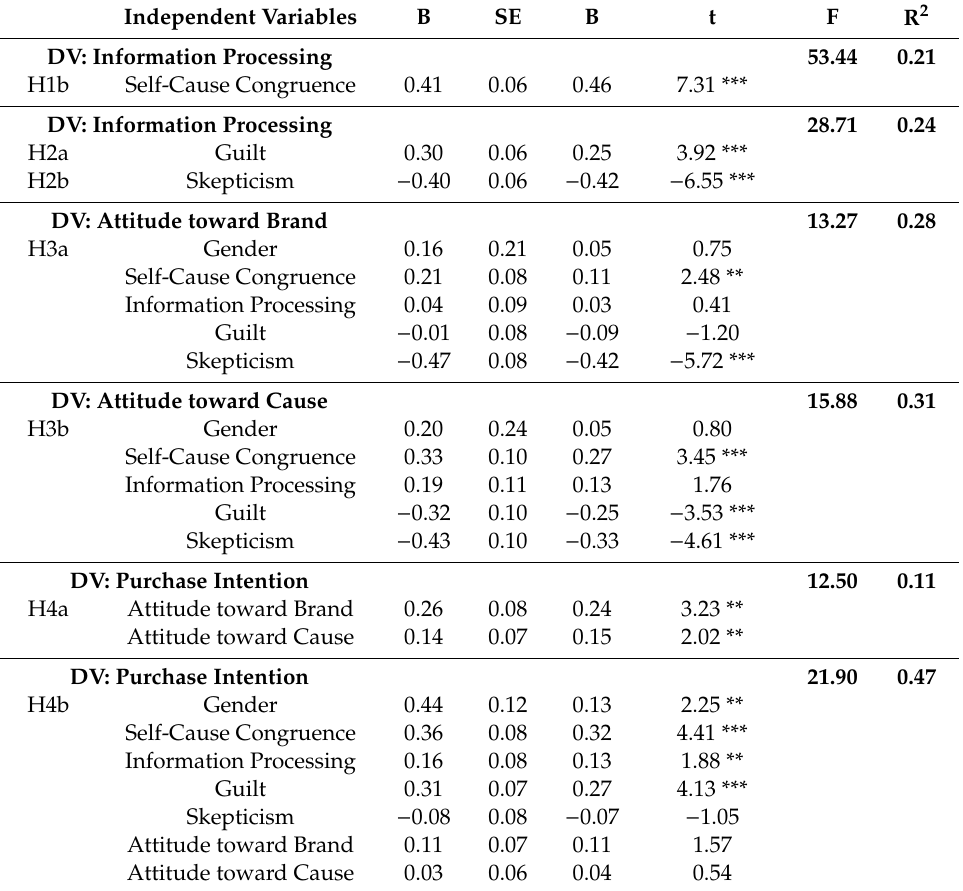
Table 1. Regression analysis